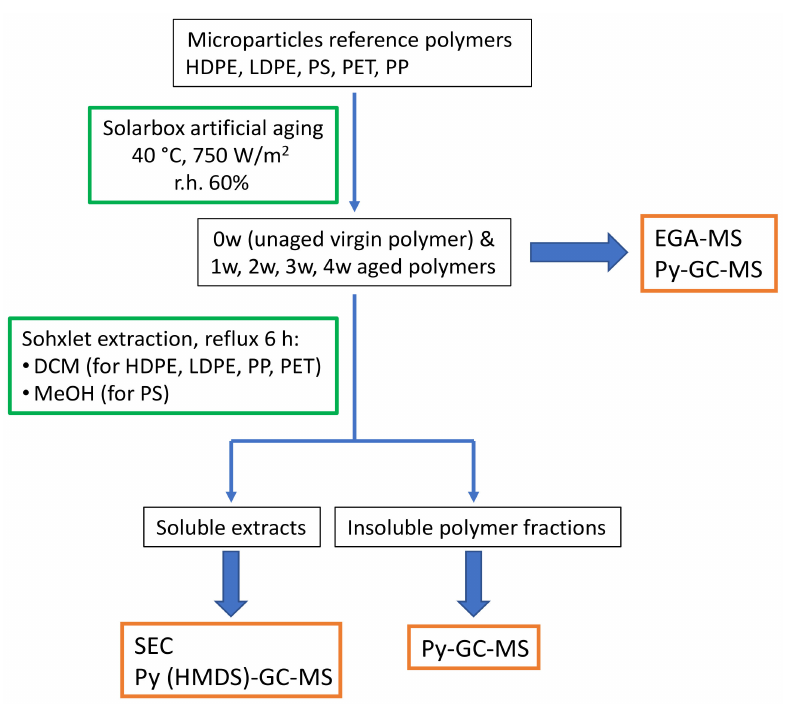
Figure 1. Flowsheet of the overall procedure for the investigation of the polymer degradation products generated upon accelerated photo-oxidative